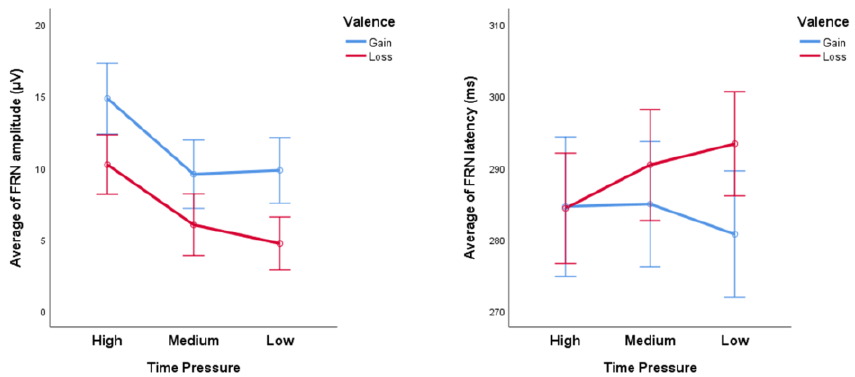
Figure 5. The average FRN amplitude ( left ) and latency ( right ) of different time pressures. Error bar = 95% confidence interval.